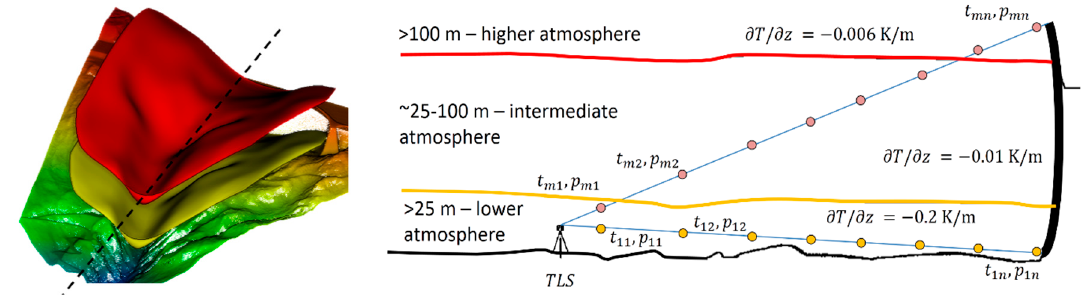
Figure 3. (Left) Spatial separation of vertical temperature gradient (VGT) layers; (right) one section of Figure 3. ( Left ) Spatial separation of vertical temperature gradient (VGT) layers; ( right ) one section of the spatial VGT model. the spatial VGT